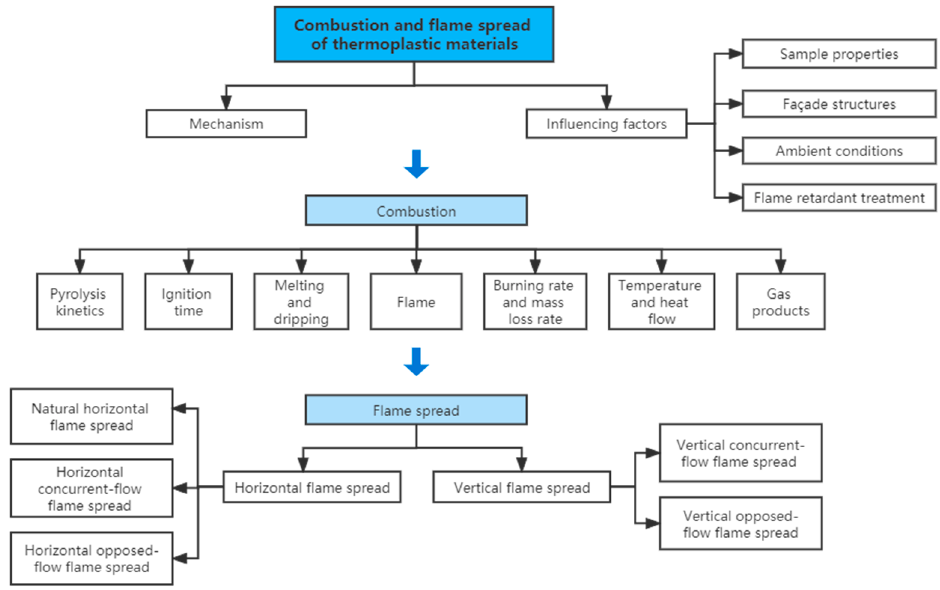
Figure 2. The combustion and flame spread of thermoplastic materials.